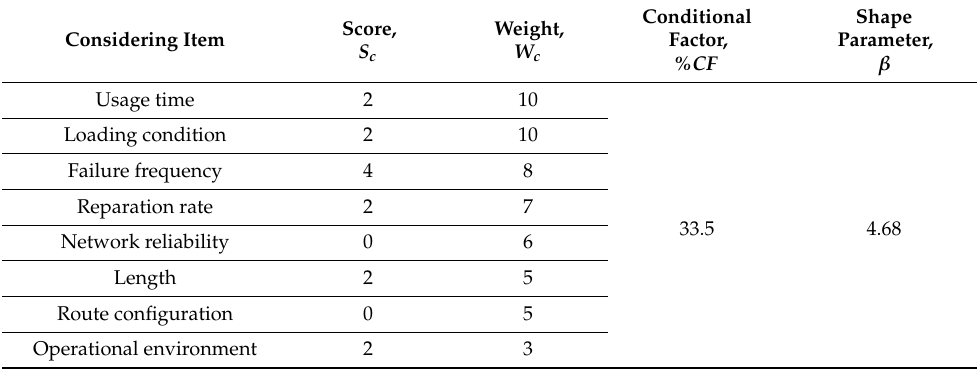
Table 5. Conditional factor calculation of feeder F-01.